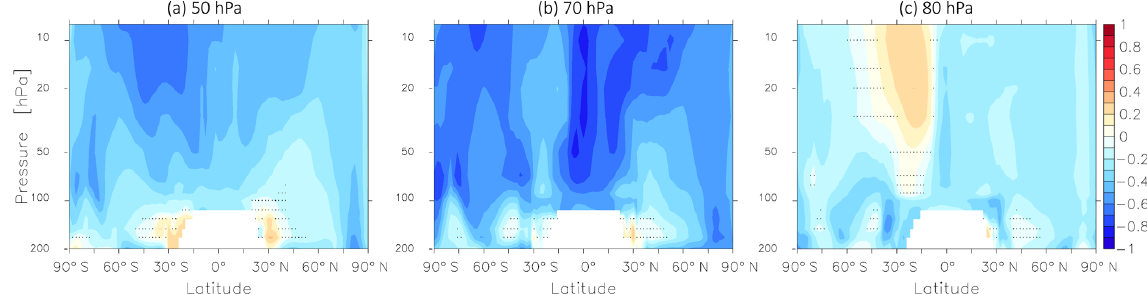
Figure 4. Inter-model correlation coefficients for the correlation between RCTTs and tropical upwelling calculated at the turnaround latitudes (a) at 50hPa, (b) at 70hPa and (c) at 80hPa. The stippled regions mark where the correlation is not significant on the 95% confidence